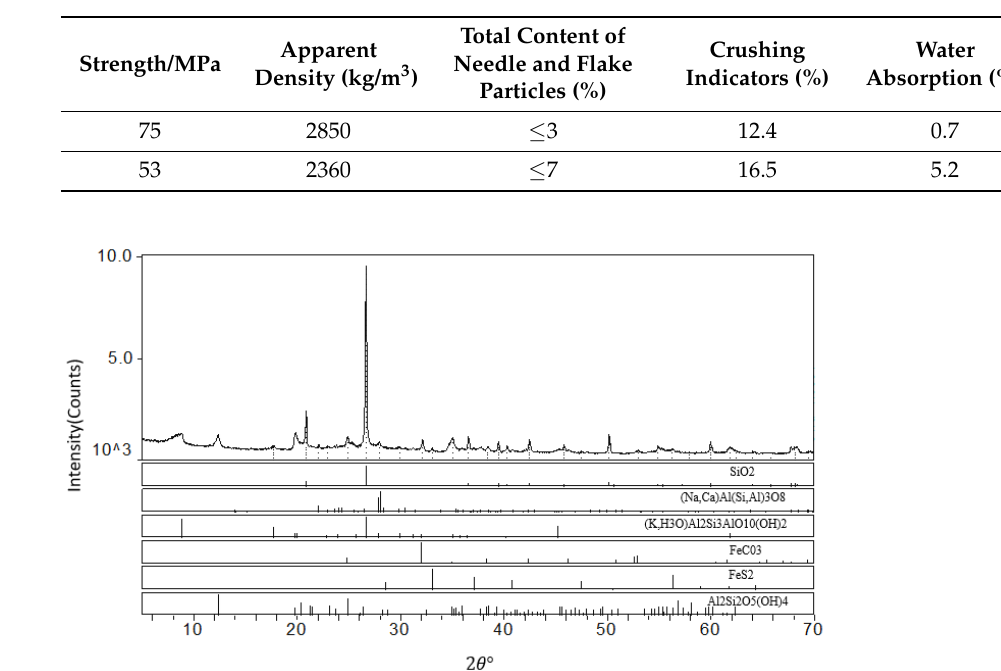
Figure 2. Gangue XRD test results.